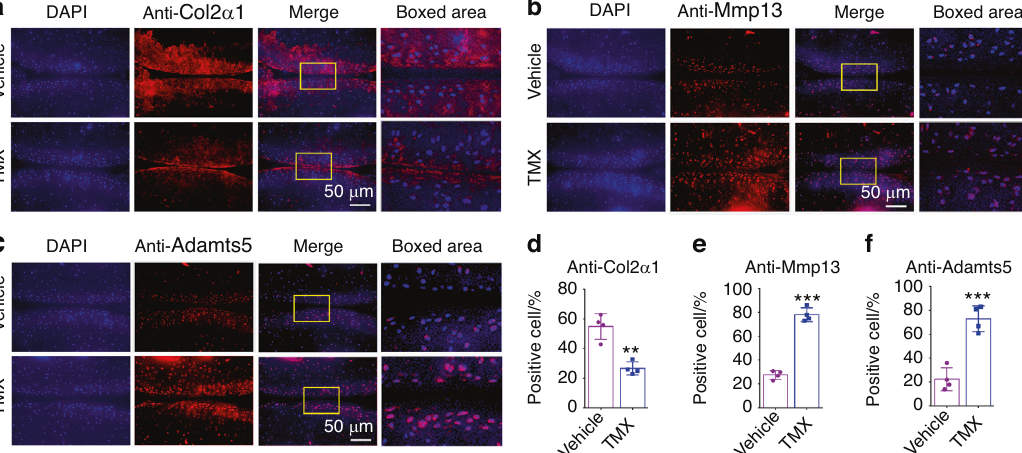
Fig. 3 Postnatal Runx1 de fi ciency in cartilage resulted in decreased Col2 α 1 expression and increased Mmp13 and Adamts5 expression. a – c IF staining with anti-Col2 α 1 ( a ), anti-MMP13 ( b ) and anti-Adamts5 ( c ) in 3-month-old male Runx1 f/f Col2 α 1-Cre ER mice induced by vehicle (control) and tamoxifen (TMX). Bar: 50 μ m. d – f Quanti fi cation of ( a – c ). The results are presented as the mean ± SD, n = 4, ** P < 0.01, *** P < orchestrating the TGF β , Hippo, and Wnt signaling pathways, Runx1 using Col2 α 1-Cre , while the study by Zhou et al. utilized thereby exacerbating a series of osteoarthritic pathological si-Runx1 in isolated chondrocyte and culture samples to silence processes, including cartilage damage and in fl ammation. Runx1. RNA-sequencing analysis using knee joints from the Runx1 f/f Col2 α 1-Cre ER mice and the wild-type control mice Loss of Runx1 in cartilage led to decreased YAP and p-Smad2/3 demonstrated that Runx1 ’ s role as a central regulator in the and increased active β -catenin Hippo/Yap, TGF β /Smad, and Wnt/ β -catenin signaling pathways Signal integration could provide a better understanding of complex in articular cartilage differed in knee joint samples compared to disease processes, and parts of these Hippo/Yap, TGF β /Smad2/3 and hip cartilage alone, indicating that Runx1 regulation is tissue- Wnt/ β -catenin pathways converge into a complex network that may speci fi c. Collectively, our data are the fi rst to demonstrate that coregulate transcriptional activators. 20 – 22 Furthermore, the expression loss of Runx1 may control downstream gene expression by